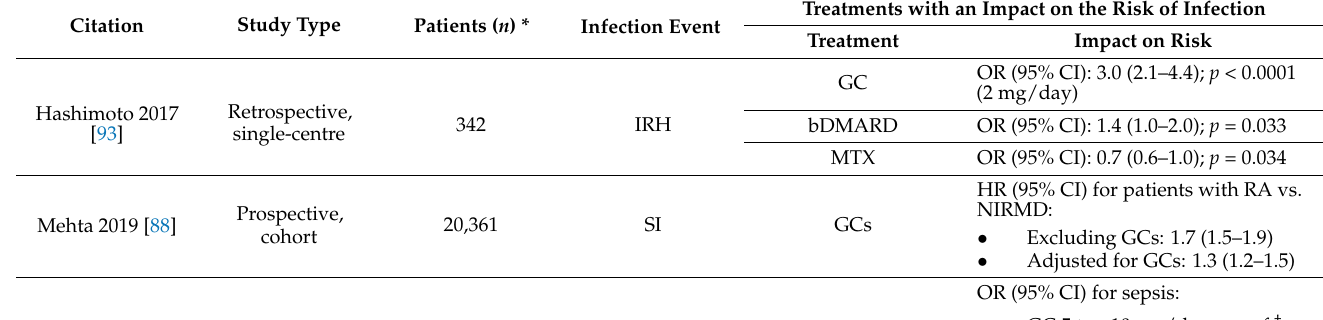
Table 4. Studies investigating associations between rheumatoid arthritis treatment regimens and the risk of infection.